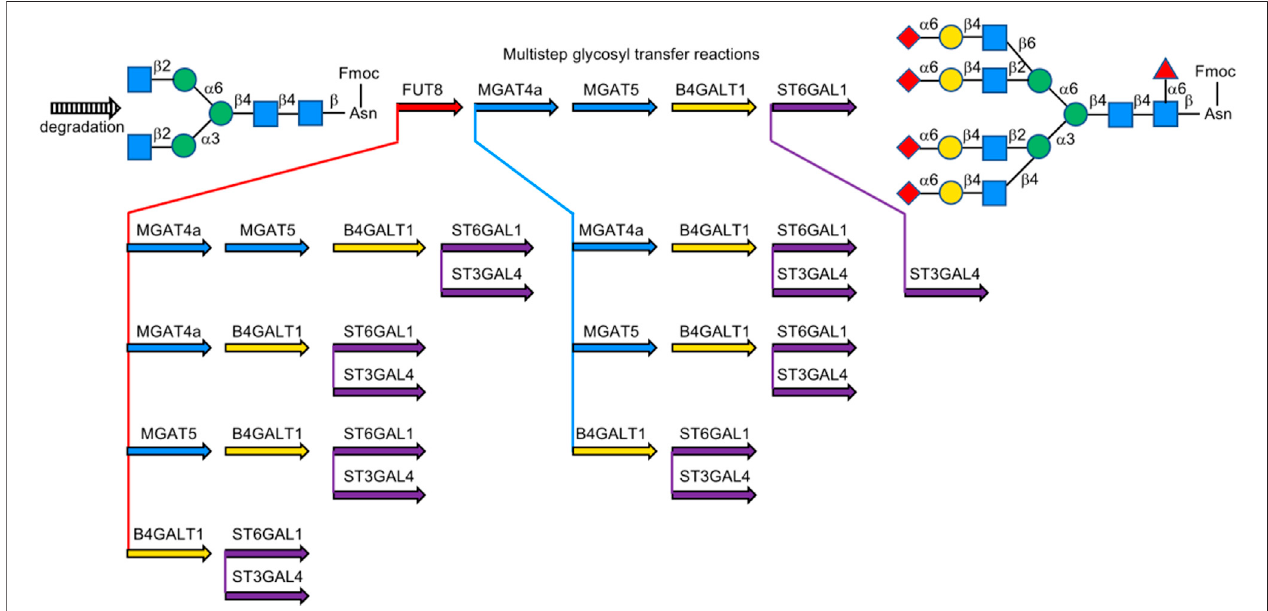
FIGURE 12 | Generation of complex-type naturally occurring N -glycans library.